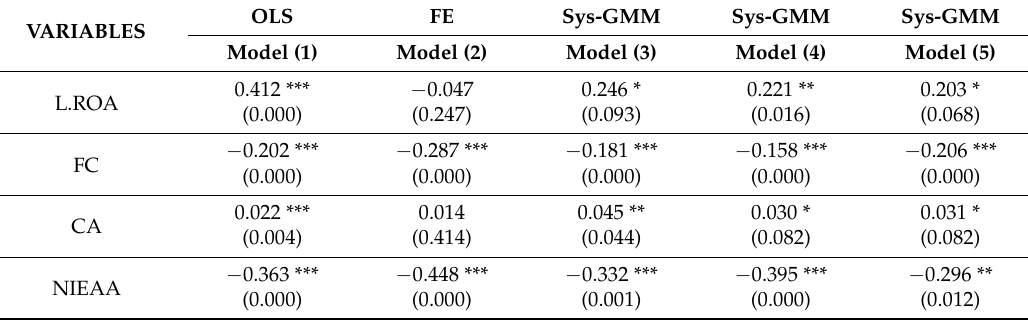
Table 9. ROA (Profitability) as dependent variable for sample excluding Indian